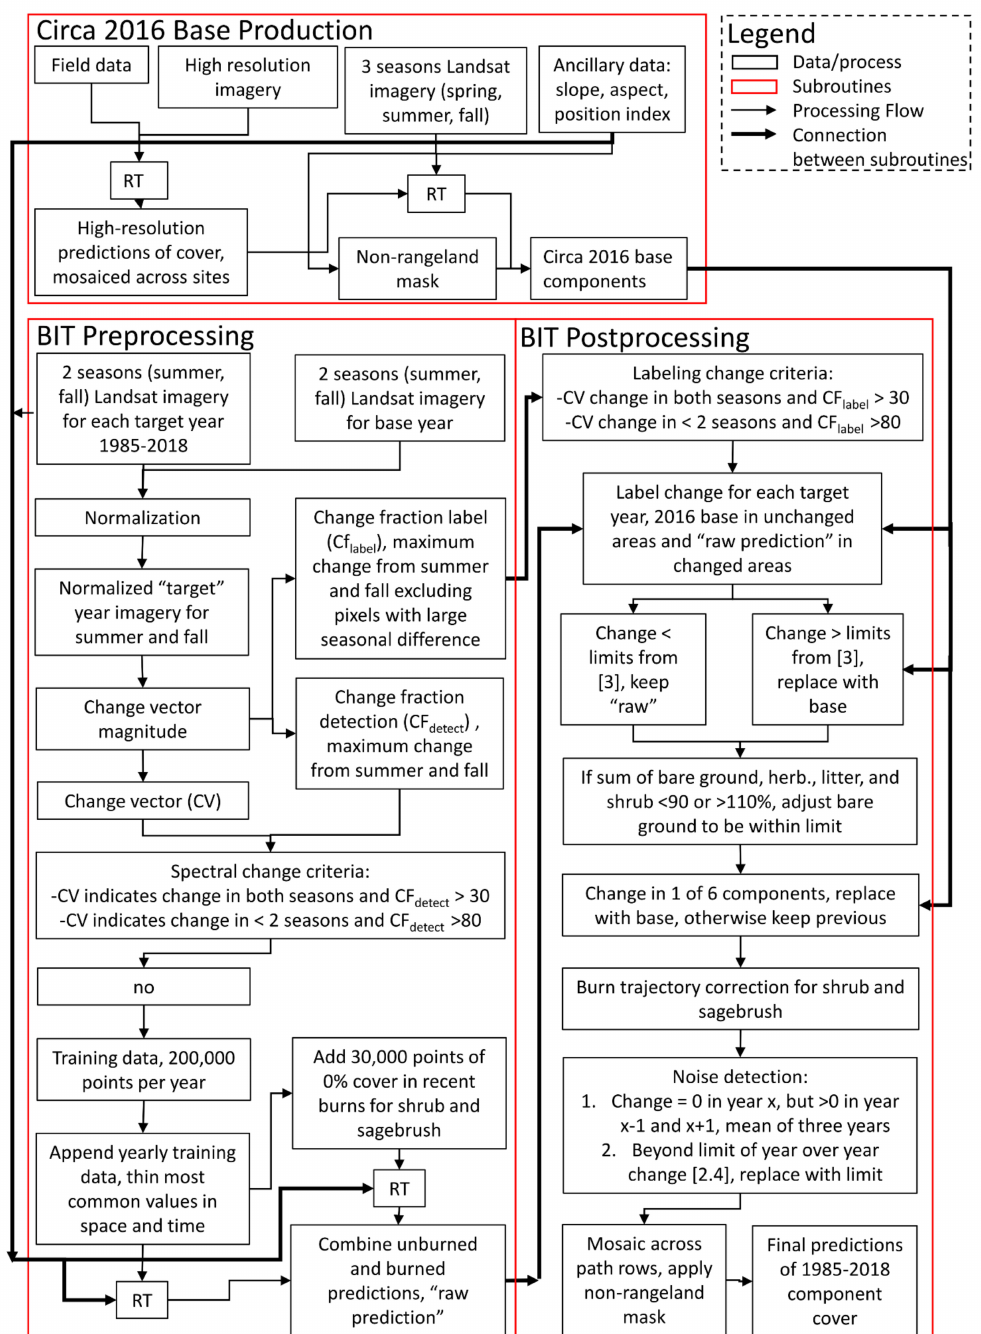
Figure 2. Flow chart of major processing steps for Back-in-Time (BIT) data production. Cubist Regression Tree (RT) models were used to generate spatial